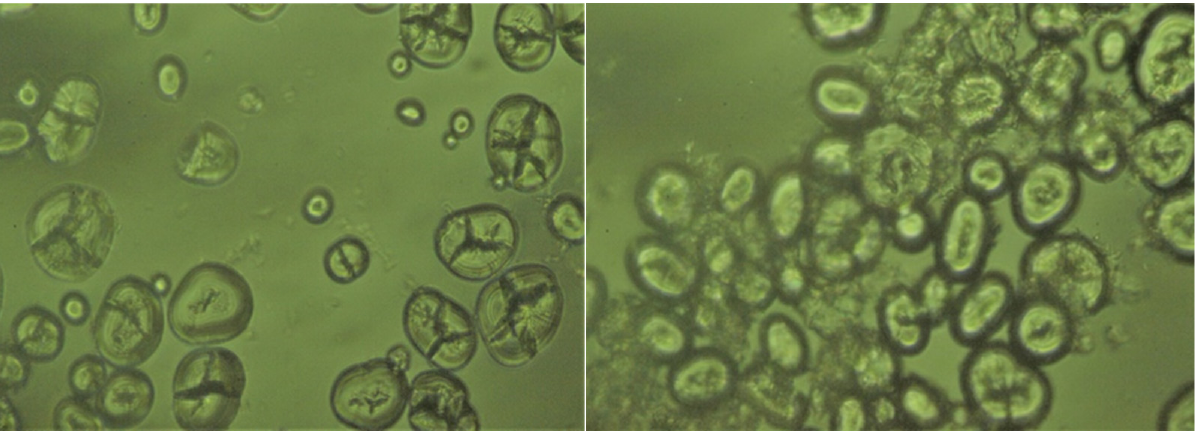
Figure 5. Polarizing microscope pictures of adzuki bean starch at the magnification (100×). CK is shown on the left, MT is shown on the right.